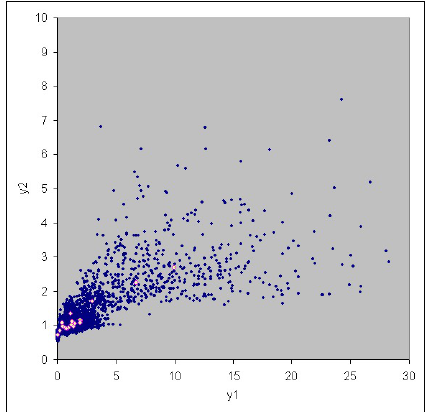
Figure 7. Simulation scatterplot of ˆ g ( y 1 , y 2 ) , m = 30. Large scale.